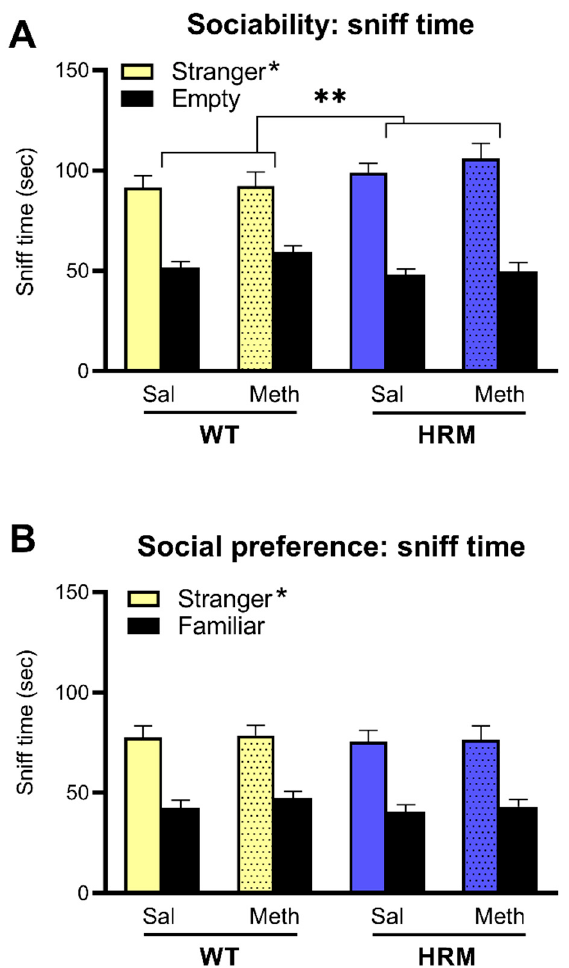
Figure 4. Social behaviour of WT and HRM pretreated with saline or Meth. Panel A shows sociability where mice showed significantly higher sniff time around the enclosure containing the stranger mouse as opposed to the empty enclosure (* p < 0.05). This difference was greater in HRM than in WT (** p < 0.05). Panel B shows social preference in the groups expressed as significantly higher sniff time around the enclosure containing the novel stranger compared to the familiar stranger (* p <0.05). There were no effects of Meth pretreatment. Data are mean ± SEM of males and females combined